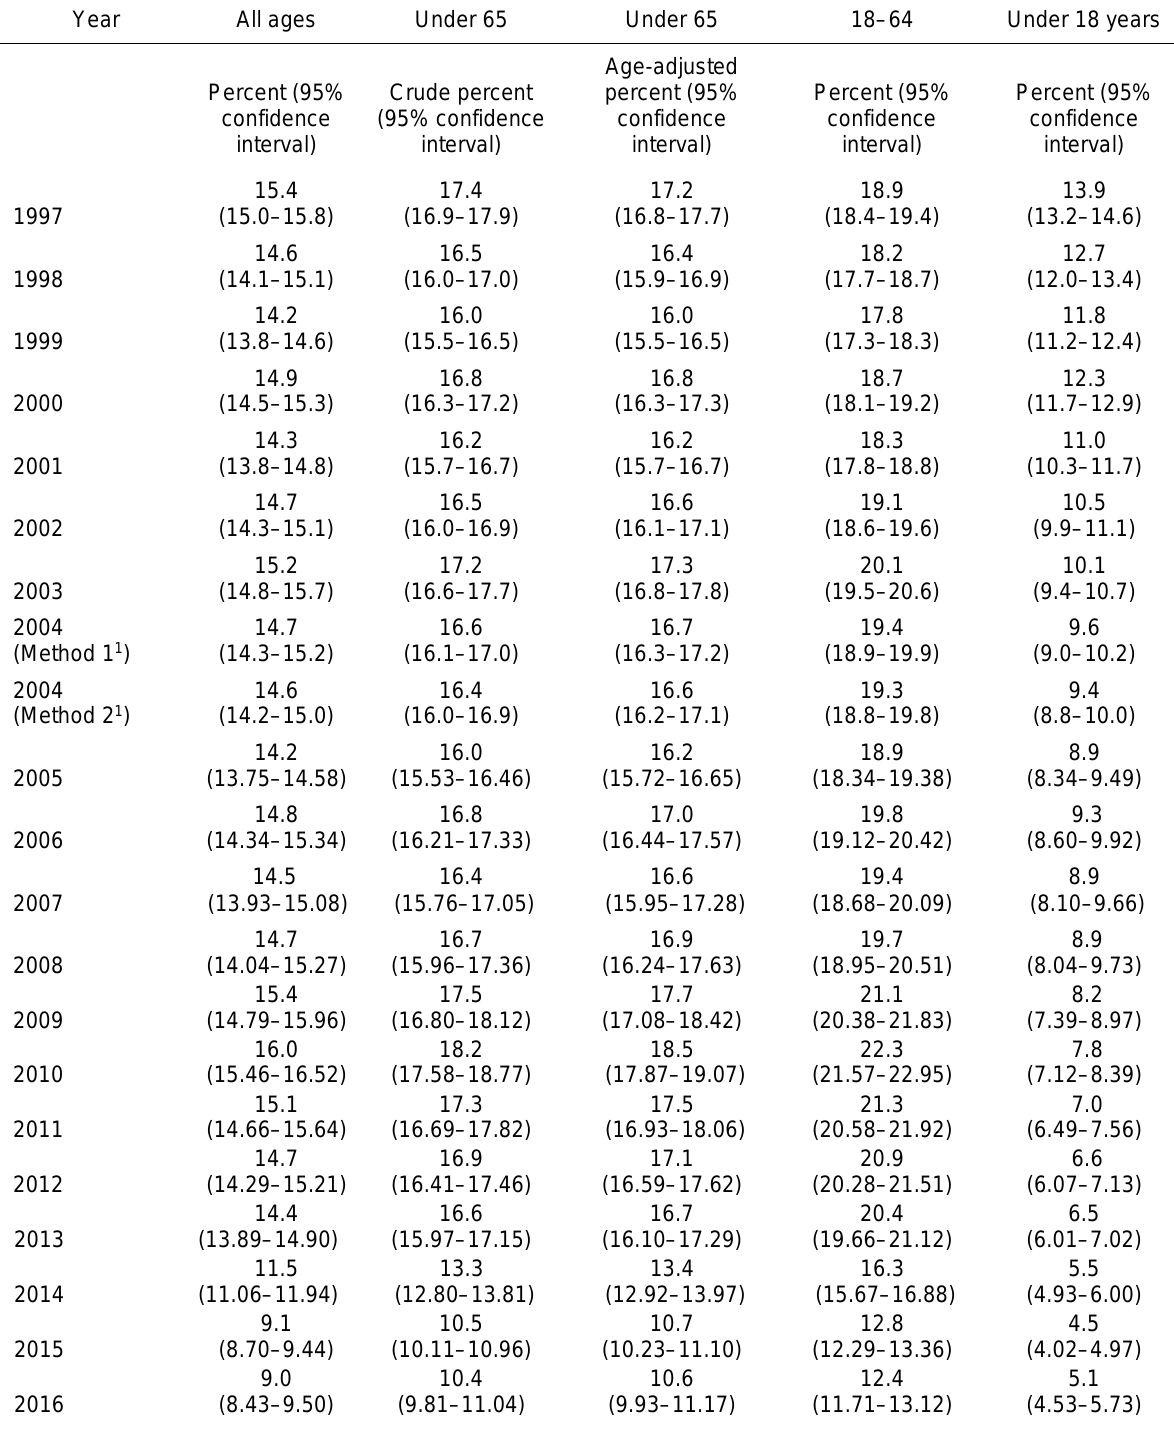
Table 1.1b. Percentage of persons without health insurance coverage at the time of the interview, by age group: United States,